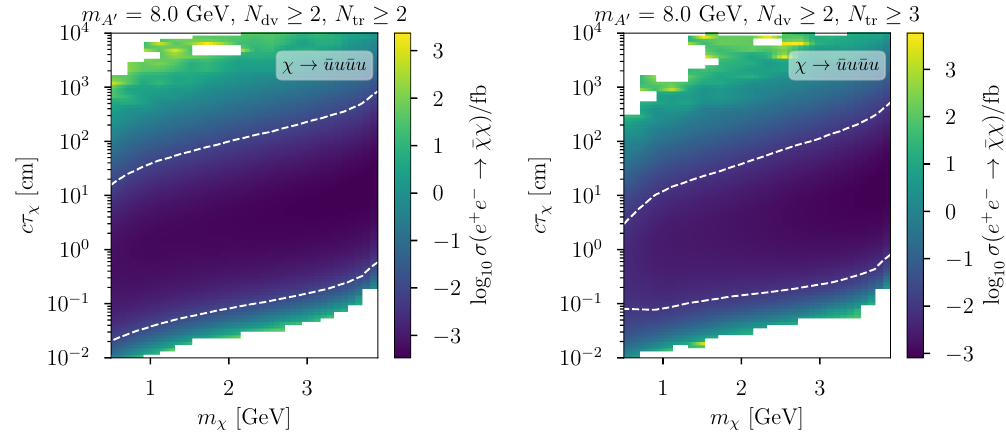
Figure 10 . Cross-section sensitivity in fb of Belle II based on 10 signal events in a 50 ab − 1 dataset for LLPs χ decaying to ¯ uu ¯ uu and the dark photon production mode. The left (right) panel shows the result of demanding at least 2 (3) charged tracks from two displaced vertices. We fix m The white dashed contours correspond to a production cross section of 10 − 2 fb , which is roughly equivalent to ε ∼ 10 − 5 for m 8 GeV A 0 ≤